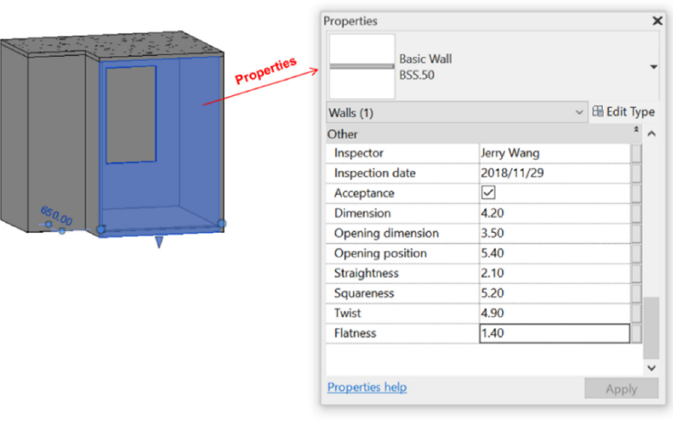
Figure 19. Example of inspection-related properties and their values of a structural element.